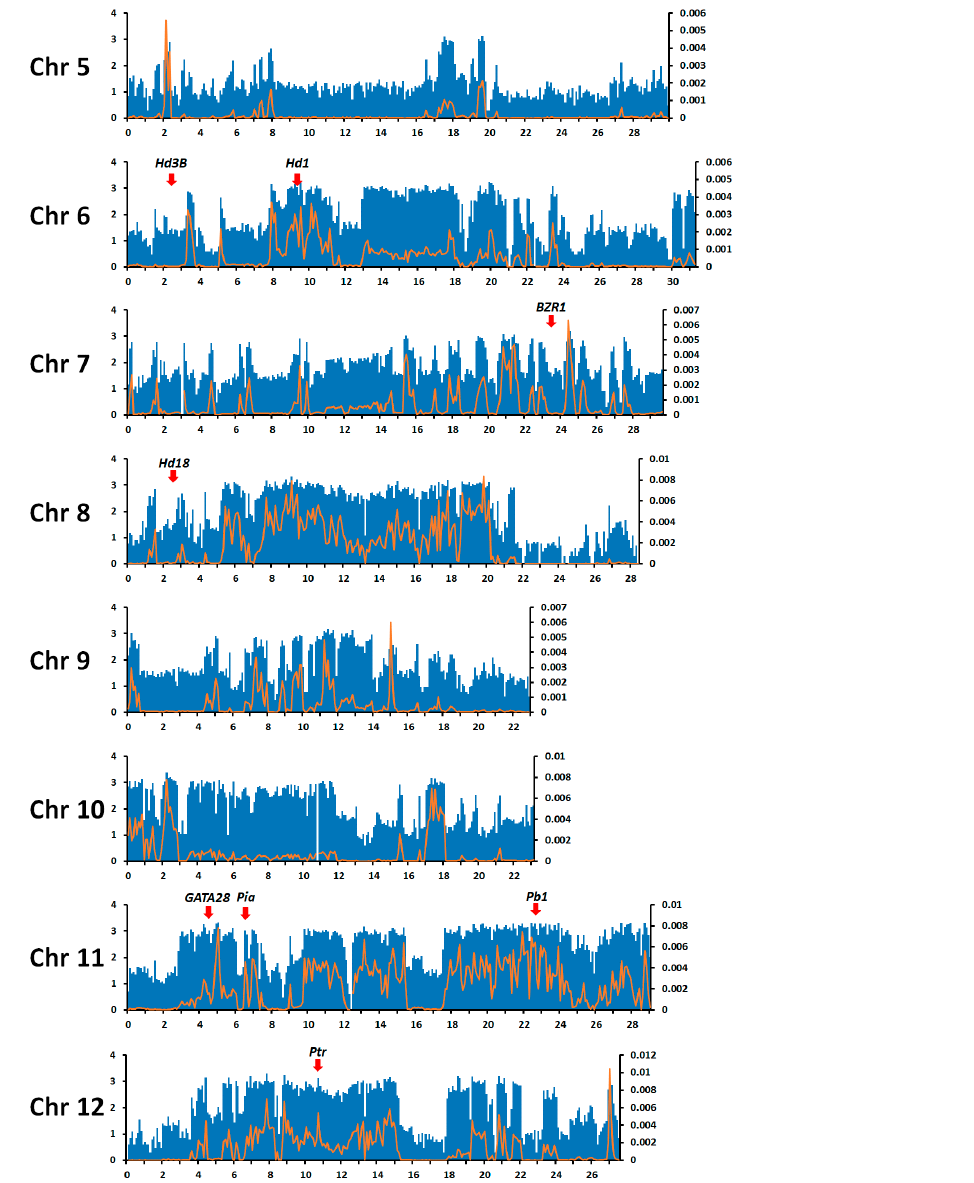
Figure 1. Distributions of sequence variation and nucleotide diversity per 100 kbp on each of the 12 rice chromosomes. X-axis shows the physical distance along each chromosome in mega base- pairs (Mbp). Left-hand Y-axis shows the common logarithm of the number of variations; blue bars show variation frequency. Right-hand Y-axis shows nucleotide diversity within 100 kbp windows ( π ), represented by the orange line. The positions of well-known agronomically important genes harboring sequence variations in 24 Korean temperate japonica rice varieties were indicated by red